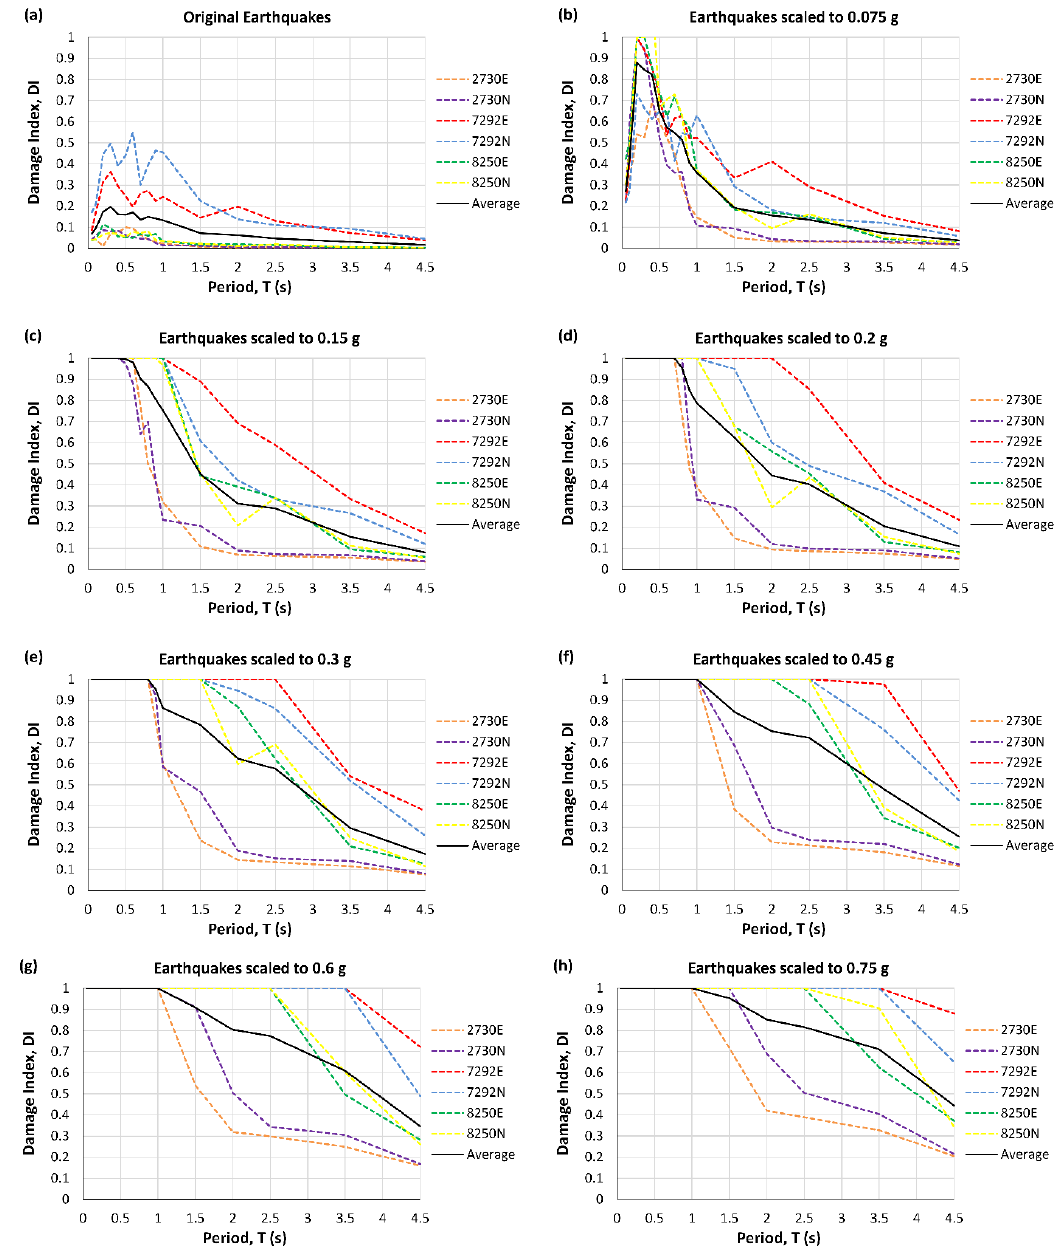
Figure 3. Park and Ang [18] DI spectral functions for seismic records: ( a ) original, ( b ) scaled to 0.075 g, ( c ) scaled to 0.15 g, ( d ) scaled to 0.2 g, ( e ) scaled to 0.3 g, ( f ) scaled to 0.45 g, ( g ) scaled to 0.6 g, and ( h ) scaled to 0.75 g.